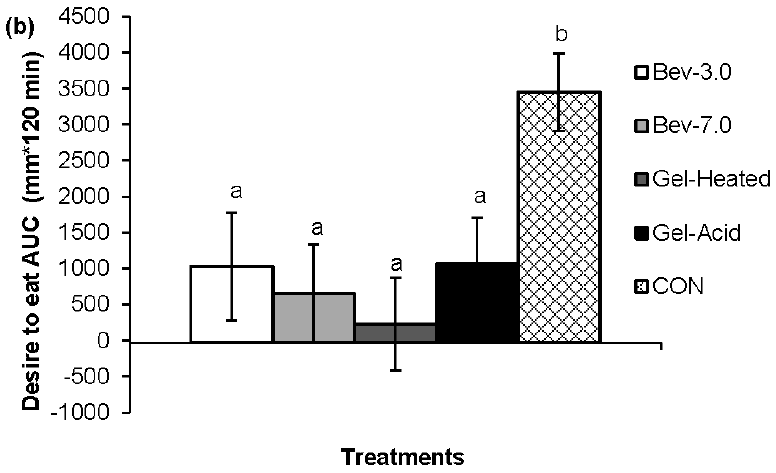
Figure 3. Perceived desire to eat across time for each treatment ( a , line graph) and the 2-h net